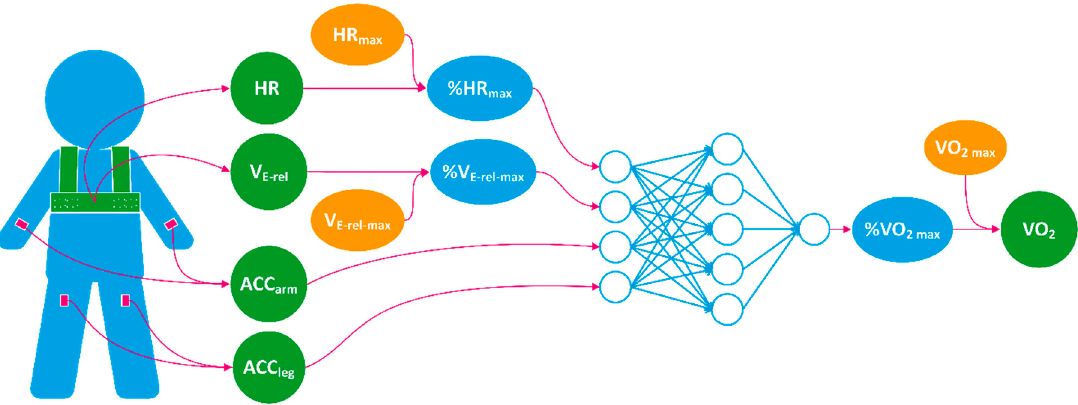
Figure 2. A demonstration of the flow of the oxygen consumption (VO 2 ) process. The input and output are explained in Table